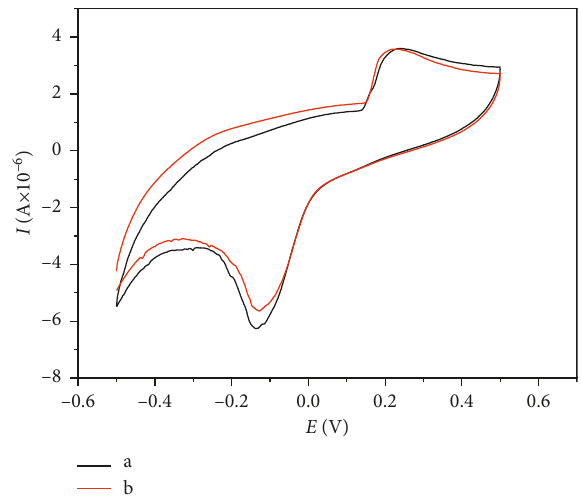
Figure 9: Cyclic voltammograms of thulium(III)-arsenazo III complex in absence of and presence of DNA (50.0mM tris-HCl buffer, pH 7.40). 5 mol 1 ; c c DNA 1 10 L Thulium (III)-arsenazo III (cid:31) 5.00 × 10 (cid:31) × · scan rate − − (cid:31)